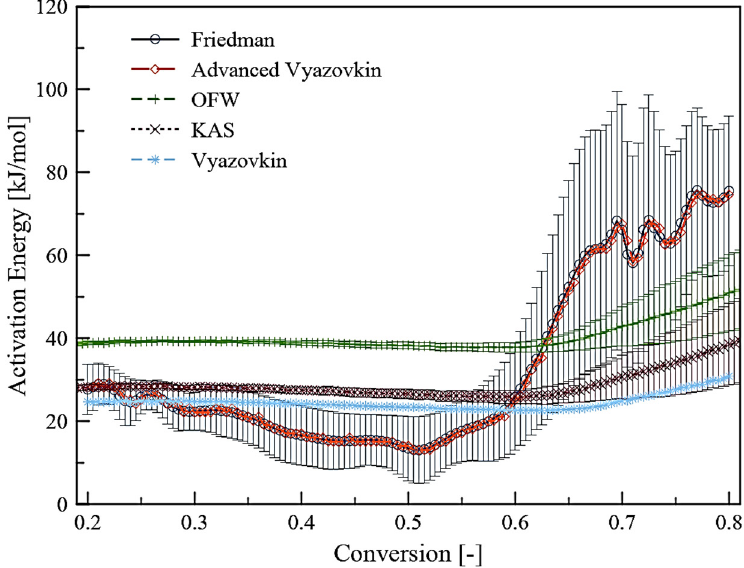
Figure 7. Activation energy as a function of conversion for the linear and non-linear methods. Table 3. Summary of E a and R 2 obtained from the fittings of each model.